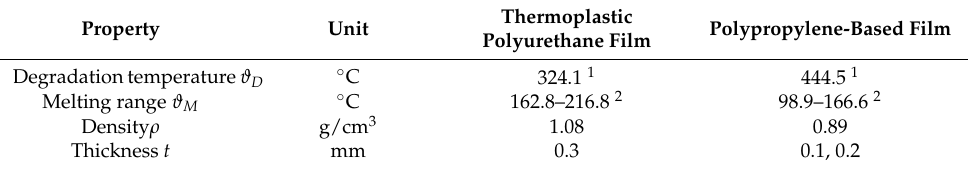
Table 1. Material and geometric parameters of the investigated film